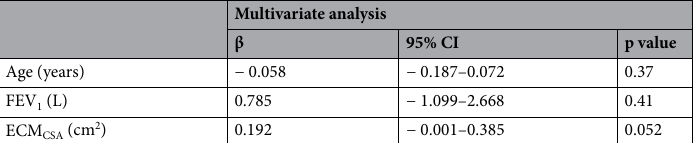
Table 6. Multivariate analysis of correlations between as predictive variables. FEV 1 forced expiratory volume in 1 s, ECM CSA cross-sectional area of erector spinae muscles, β standardized β value, CI confidence